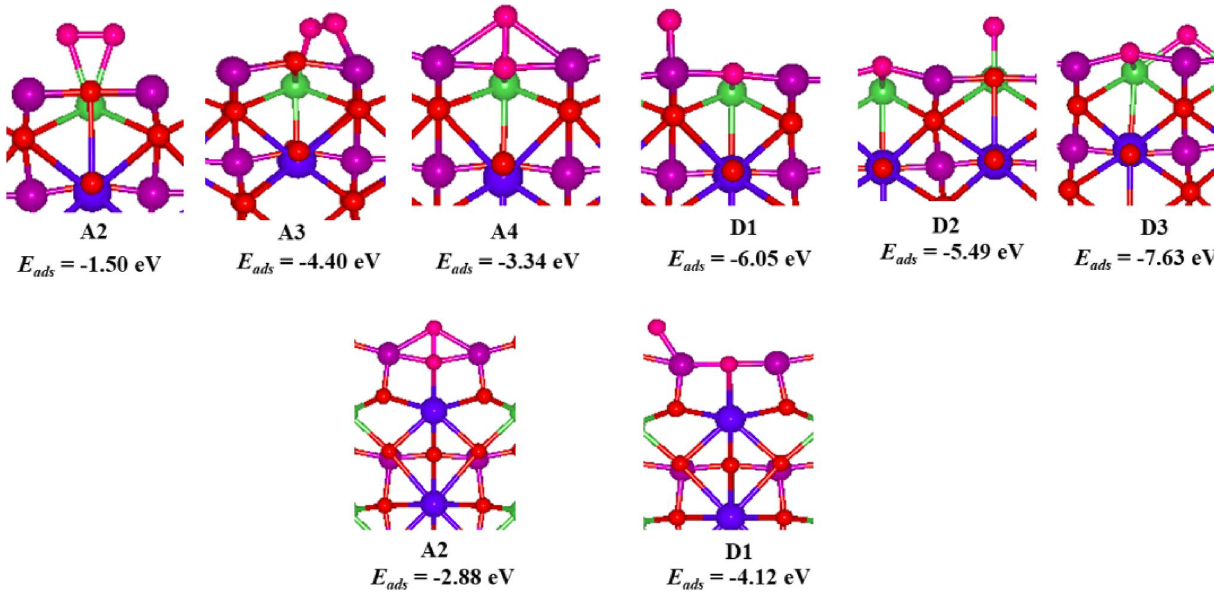
Fig. 4 Side views of the optimized geometries of oxygen molecule on defective (2 × 1)-{110} (top) and {100} (down)